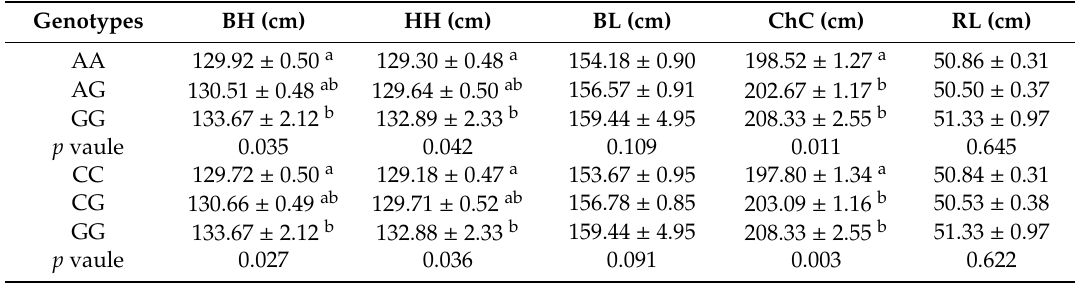
Table 4. Association analysis of single SNP in RET with body measurements in Qinchuan